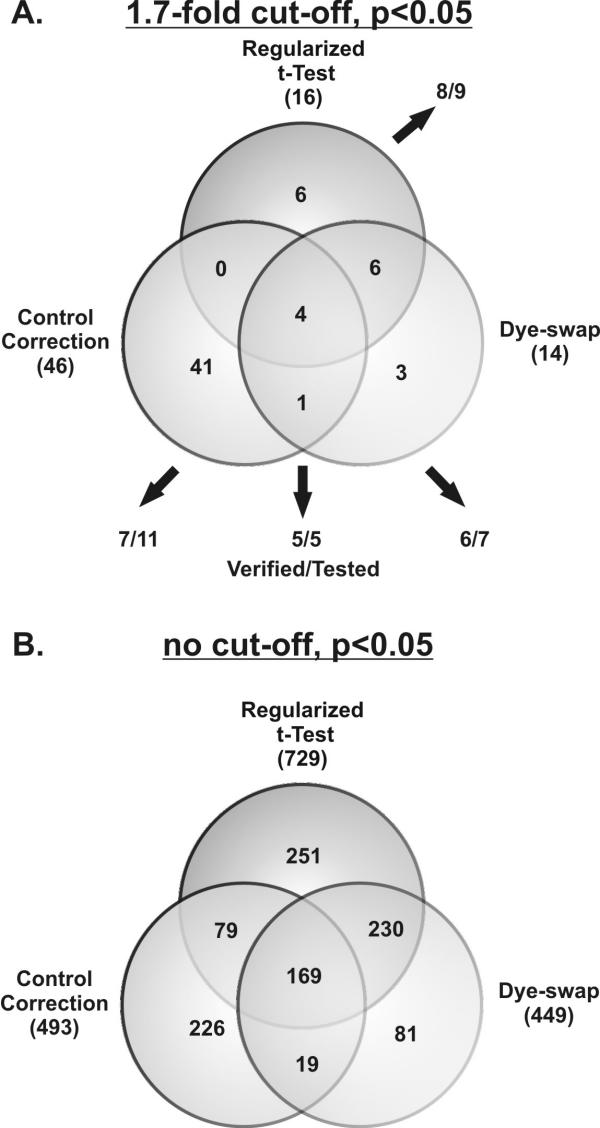
Summary of confirmation rates for the two methods. (A) A Venn diagram summarizes the number of genes identified by each experimental method using 1.7-fold and p < 0.05 cut-offs and the verification rate by northern blot. While all 5 genes common to both methods were confirmed, 7 out of 11 genes from control correction method were confirmed, and 6 out of 7 genes from the dye-swap method using the ANOVA were confirmed. 8 out of 9 genes identified with the regularized t-test were confirmed. (B) A Venn diagram summarizes the number of genes identified by each experimental method of p < 0.05 without a fold change restriction.